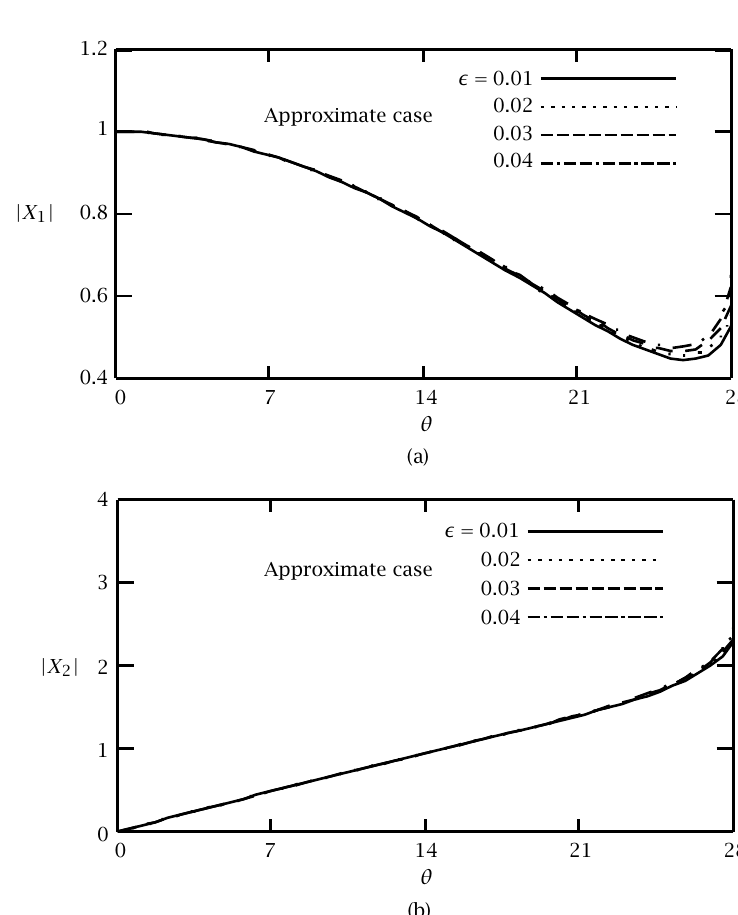
Figure 10 . (The thermal effect in the approximate case) | X 1 | , | X 2 | versus the angle of incidence θ